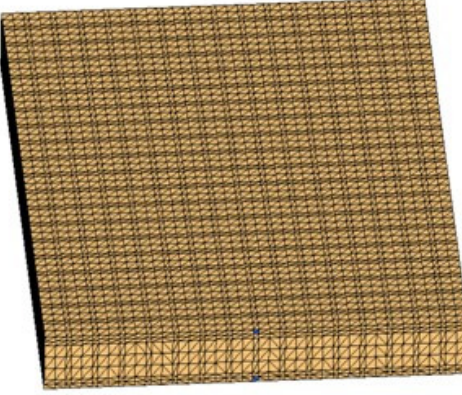
Figure 5. 3D model of foam sandwich composite.